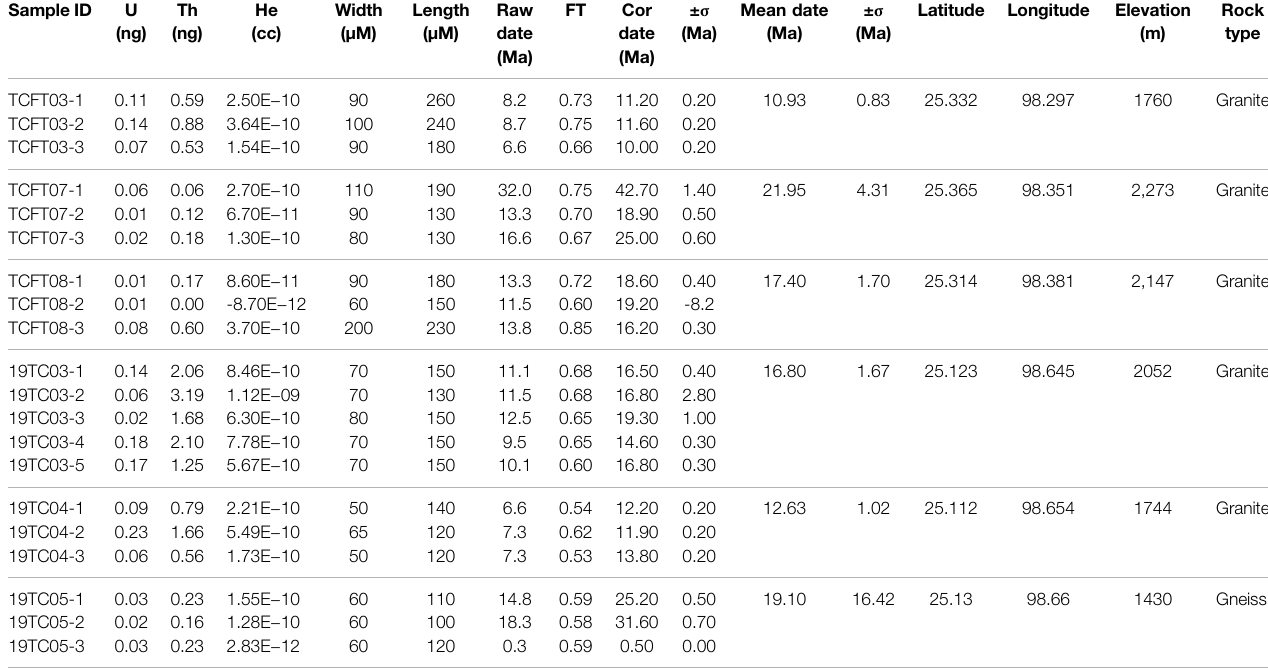
TABLE 3 | Results of the apatite single particle (U-Th)/He analysis in the GY and YHG transects.